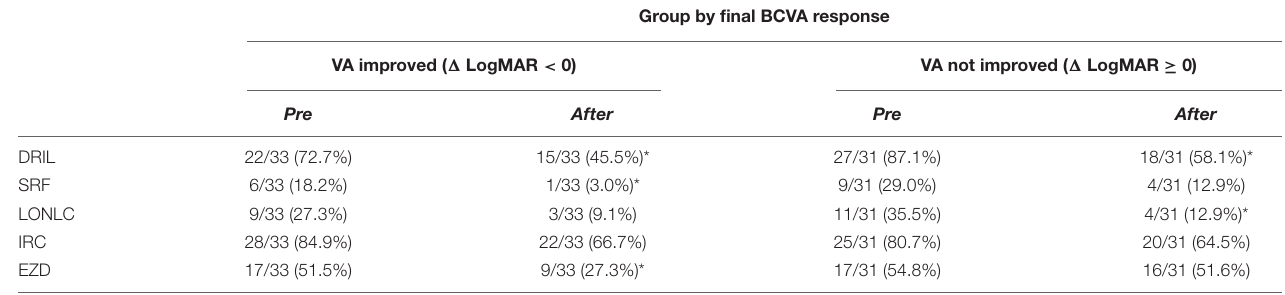
TABLE 6 | Changes of OCT biomarkers presentation in groups and by final BCVA